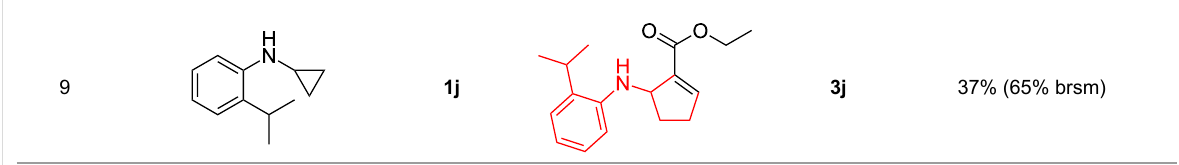
9 1j 3j 37% (65% brsm)